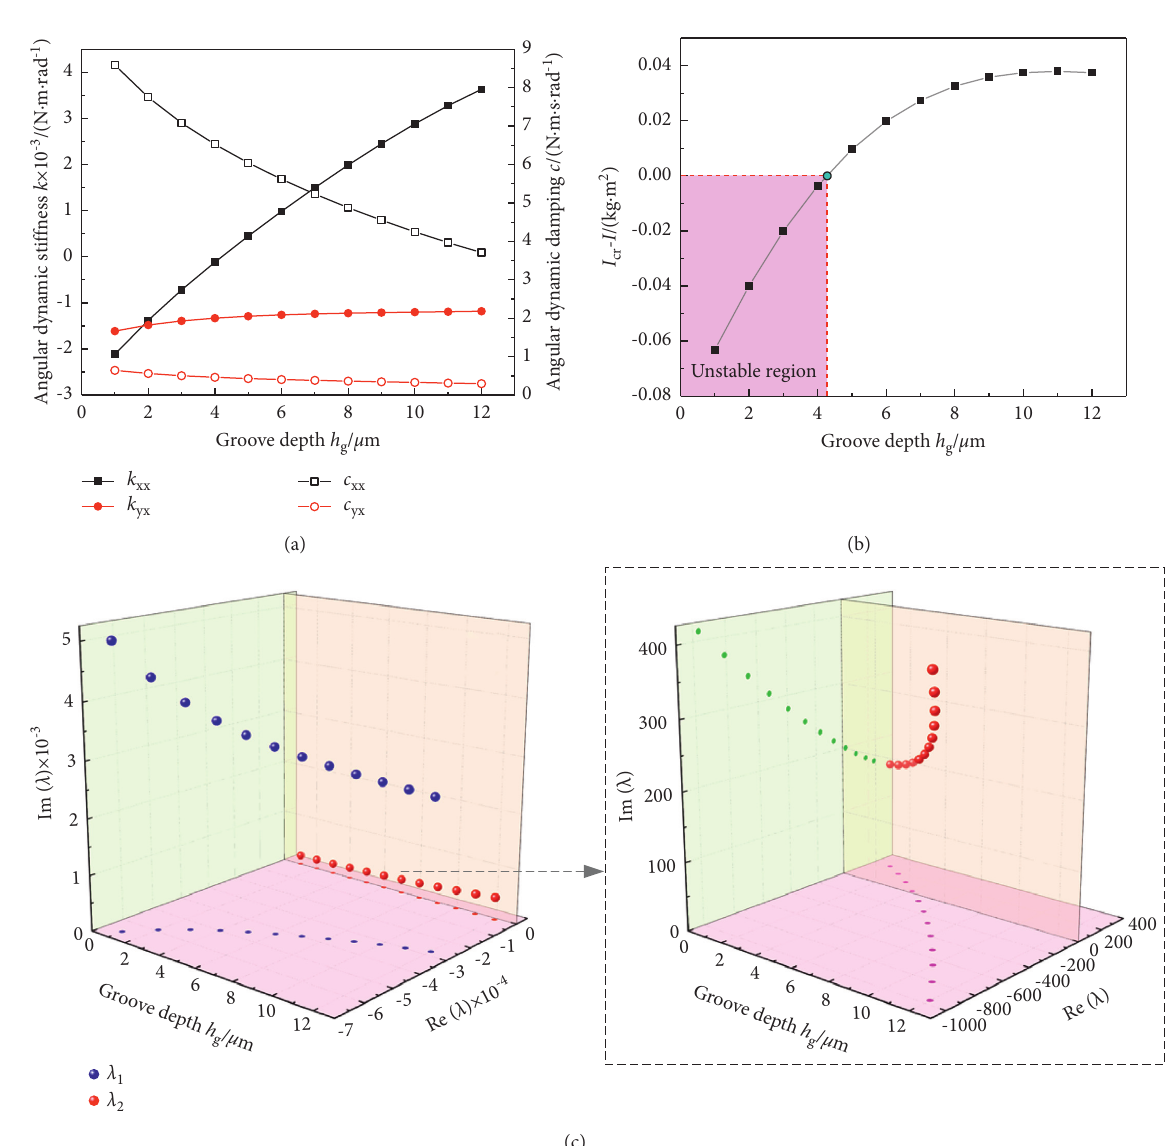
Figure 8: Variation of dynamic characteristics of DGS with groove depth: (a) film dynamic coefficients; (b) critical rotational inertia; and (c) root